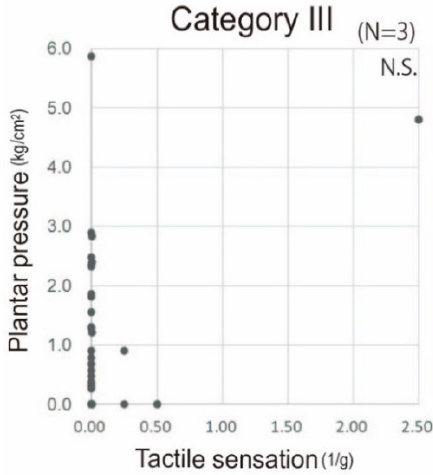
Figure 4. Relationship between dynamic pressuring and sensory function according to the severity of sensory disturbance; The correlation between dynamic plantar pressure and tactile sensory threshold is presented for each clinical category of Hansen’s disease in which more than one foot was classified (Category I, n = 7, grossly normal foot without scarring, but with decline of sensation; Category II, n = 8, grossly normal foot with scarring or callus commonly at the ball of the foot; and Category III, n = 3, foot with deformity that does not affect either the length or the width) [24]. A significant correlation was observed in Category II ( p = 0.016, r 2 = 0.246), while no significant correlation was observed in the other categories ( p > 0.05).